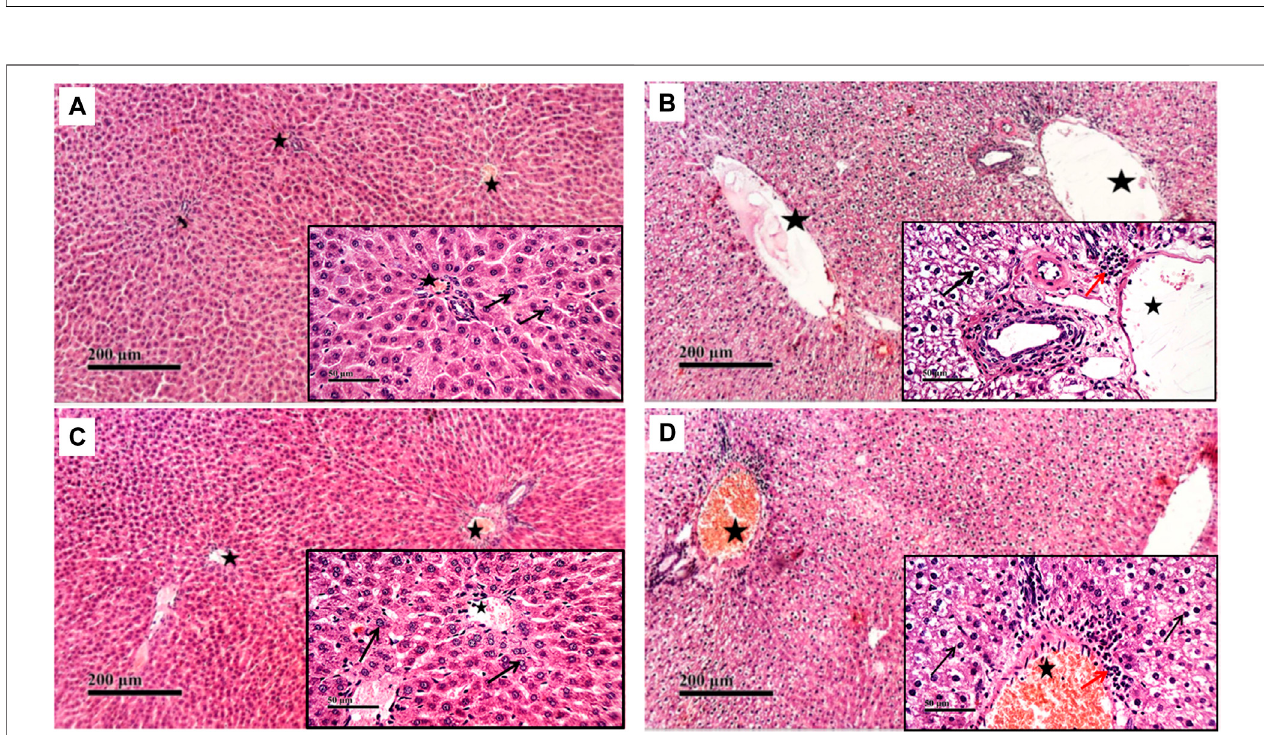
FIGURE 2 | Effect of NaHS and PAG on rats ’ liver tissues stained with hematoxylin and eosin (H&E) in CP- induced hepatotoxicity (×200 and ×400). Liver tissue of control group (A) showed normal morphological features of hepatic parenchyma with many apparent intact radiating hepatocytes. Liver tissues of rats treated with CP (B) showedseverdiffusehepatocellularvacuolardegenerationwithkaryopyknosis(arrow)accompaniedwithmoderatedilatationofhepaticbloodvessels(star)andmild records of periportal in fl ammatory cells in fi ltrates (red arrow). Liver tissues of NaHS rat group) showing intact histological structure of hepatic lobule with few degenerative changes (black arrow) mild hepatic blood vessel dilatation (star) or in fl ammatory cells in fi ltrates (C) . microscopic examination of liver tissues of PAG rat group (D) showed wide diffuse areas of vacuolar degenerative changes of most of hepatocytes (arrow) with many dilated, congested hepatic blood vessels (star) and mild records of focal perivascular in fl ammatory cells in fi ltrates (red arrow).